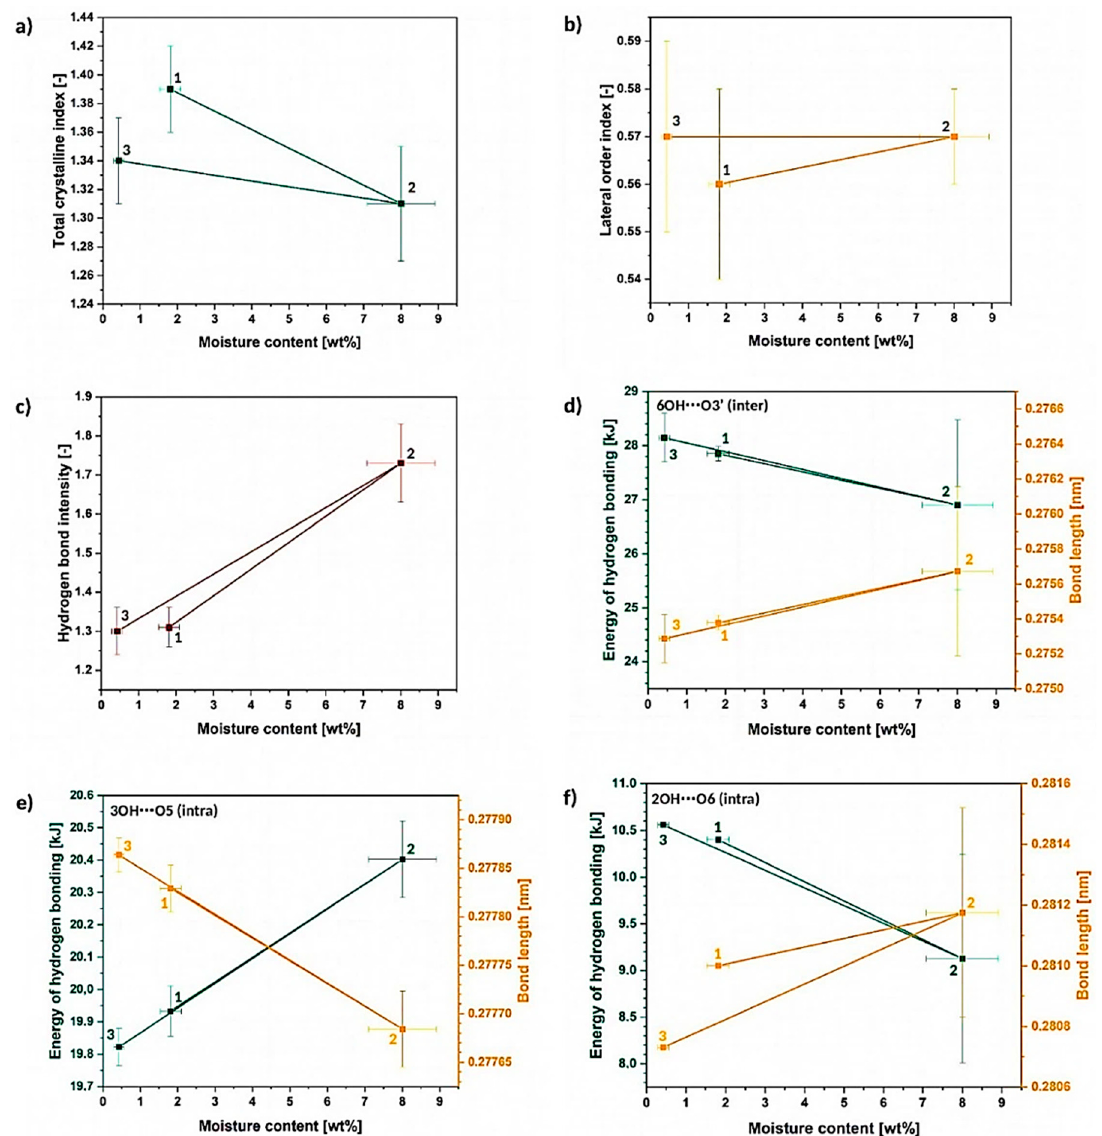
Figure 11. Differences between the different cellulose states: 1. before the experiment, 2. after 24 h of moisture absorption and 3. dried cellulose, regarding the changes in: ( a ) TCI, ( b ) LOI, ( c ) HBI, as well as variations in the energy and length of hydrogen bonds: ( d ) 6OH ⋯ O3 ′ , ( e ) 3OH ⋯ O5, ( f ) 2OH ⋯ O6.